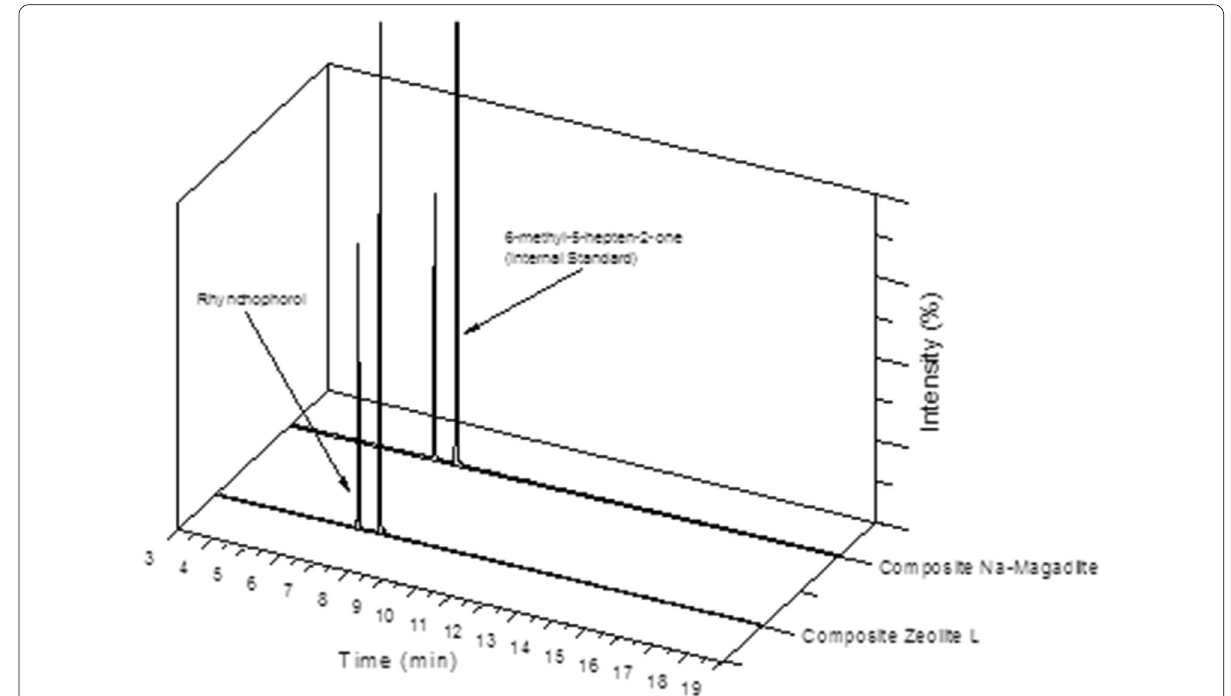
Fig. 4 Chromatograms of the solutions recovered from the Na-magadiite and zeolite L